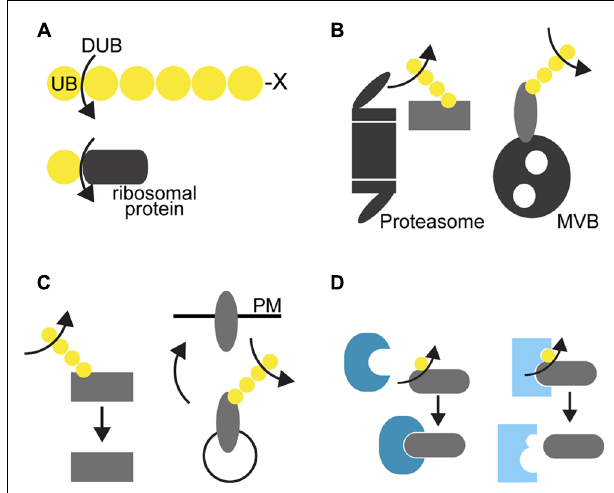
FIGURE 1 | Cellular function of DUBs. (A) Ubiquitin is translated as tandem ubiquitin repeats with several amino acid extension (depicted as X) at the C-terminus or as fusion to ribosomal proteins in plants. DUBs process the peptide bond between ubiquitin and its fusion protein to produce ubiquitin monomers that can be then conjugated to its substrate proteins. (B) DUBs can remove ubiquitin chains from its target proteins and recycle ubiquitin molecules prior to degradation by the 26S proteasome (left) or before the sequestration into the intraluminal vesicles of the multivesicular body (right). Deubiquitylation can start at the distal end as shown here or at the proximal end or in the interior of polyubiquitin chains. (C) Removal of the ubiquitin chains by DUBs can inhibit their recognition by the degradation machinery and thus rescues them from degradation regardless whether the protein is a cytosolic proteasomal substrate (left) or a membrane cargo (right). (D) Ubiquitylation can serve as an interaction signal for the modified protein. By removing the ubiquitin moiety, DUBs could change the binding affinity of its target protein to another protein, either by enabling (left) or by disabling the binding of the unmodified protein to its interacting